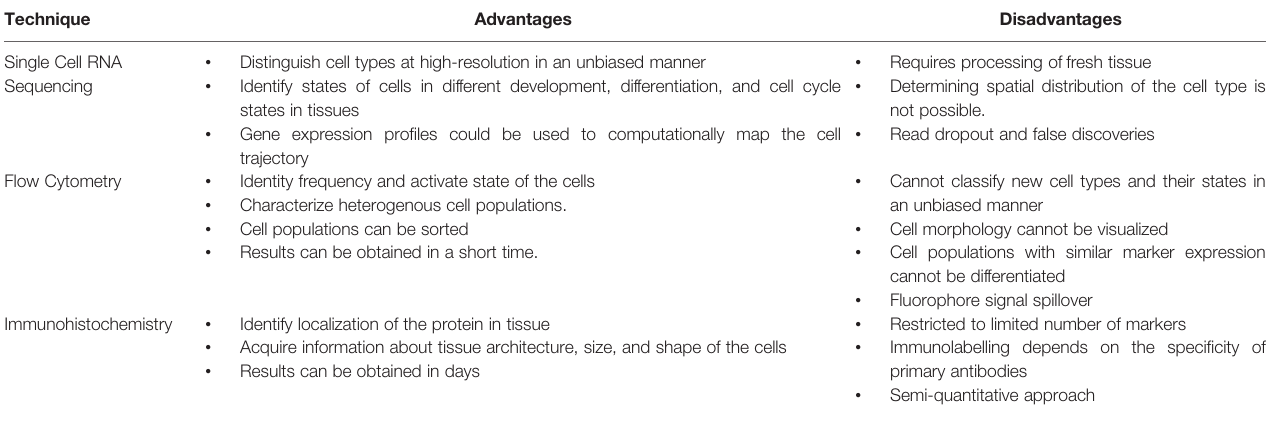
TABLE 1 | Advantages and disadvantages of technologies used for classifying myeloid compartments in pancreatic cancer. Technique Advantages Disadvantages Single Cell RNA Sequencing